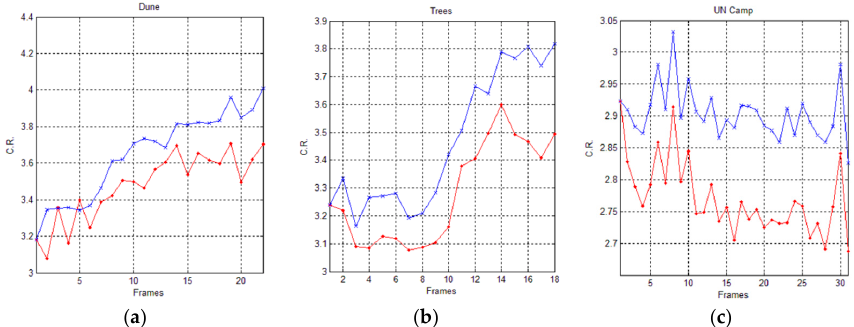
Figure 12. Graphical comparison of the achieved C.R. between the AVQ IS algorithm (blue line) and the AVQ algorithm (red line), by using a dictionary of 8192 (2 13 ) entries, for ( a ) the Dune sequence; ( b ) the Trees sequence; and ( c ) the UN camp sequence.